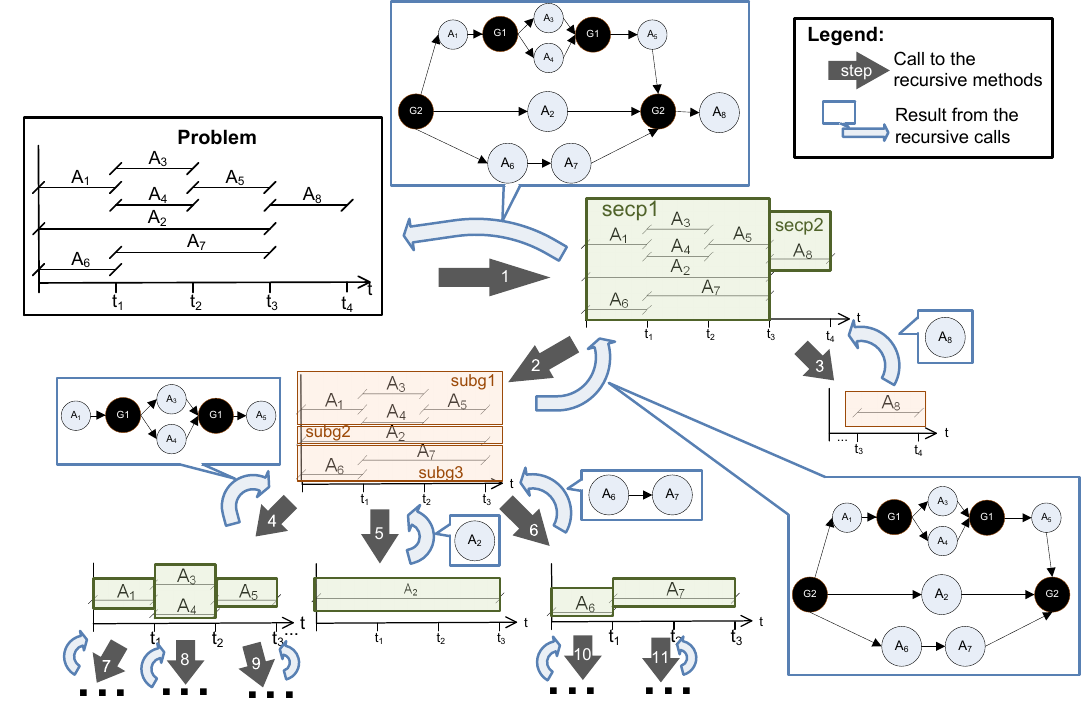
Figure 8. Trace example of the Algorithm to create a BPMN-Graph using the COP